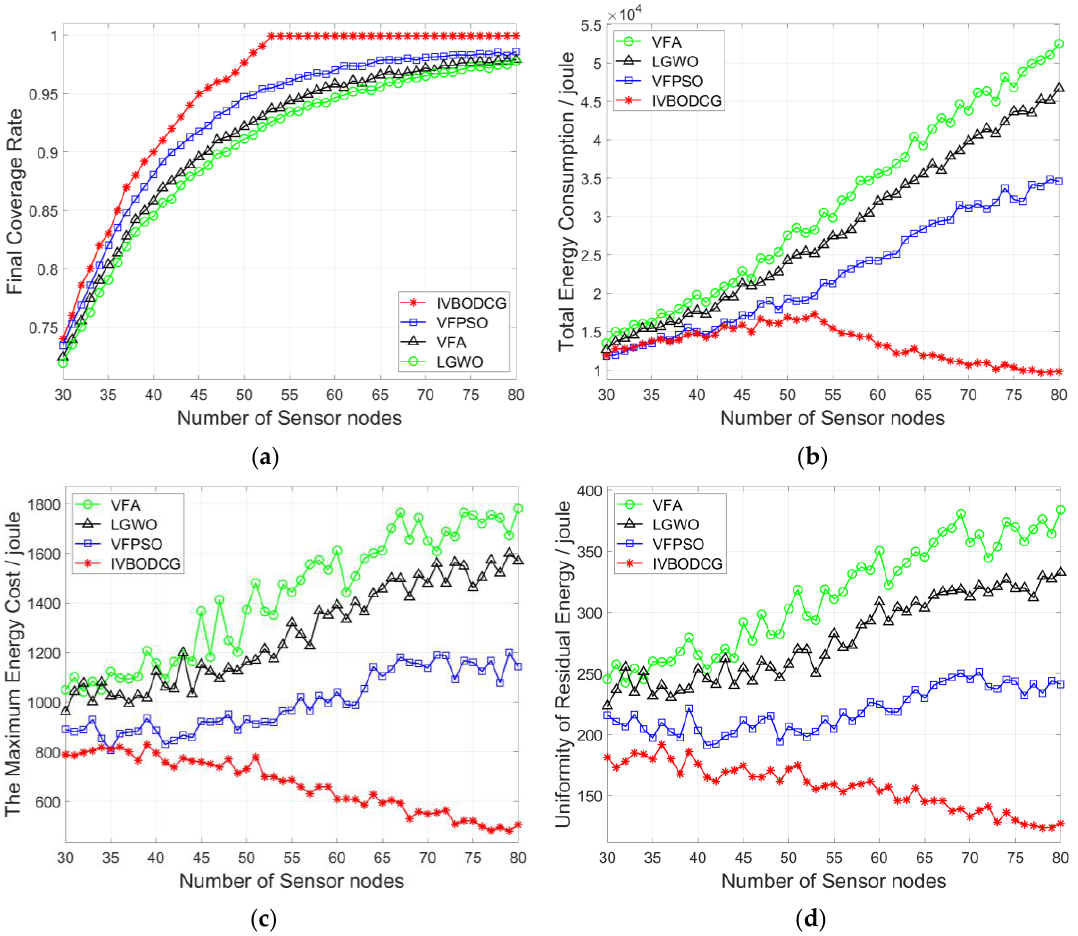
Figure 16. Comparison of four algorithms when the number of sensors changes. ( a – d ) show the final coverage rate, total energy cost, the maximum energy cost and uniformity of residual energy of four algorithms, respectively.